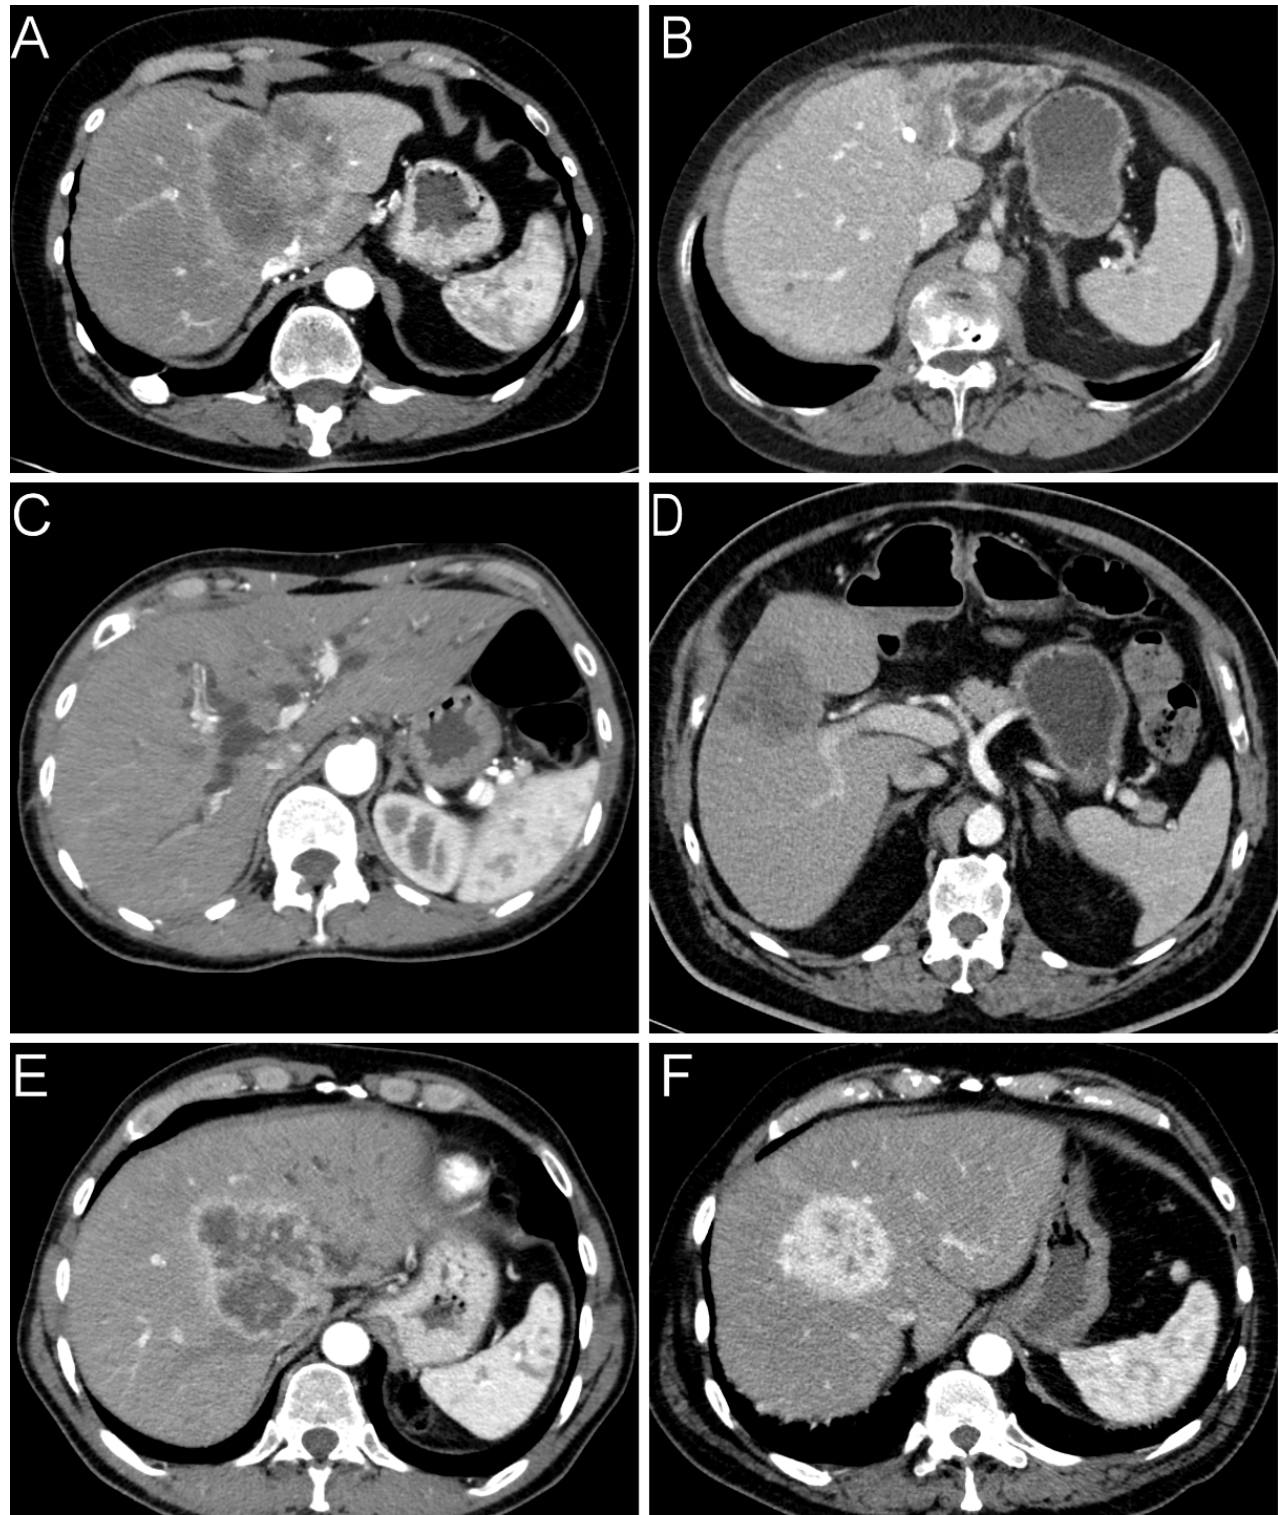
Figure 1. Radiological features of iCCAs. We differentiated two types of growth patterns: ( A ) mass- forming and ( B ) ductal-growing (in this case with an inserted biliary drainage). ( C ) Obstruction of bile ducts. Contrast agent behavior in the late arterial phase: ( D ) hypodense; ( E ) rim-enhanced; ( F ) hyperdense.